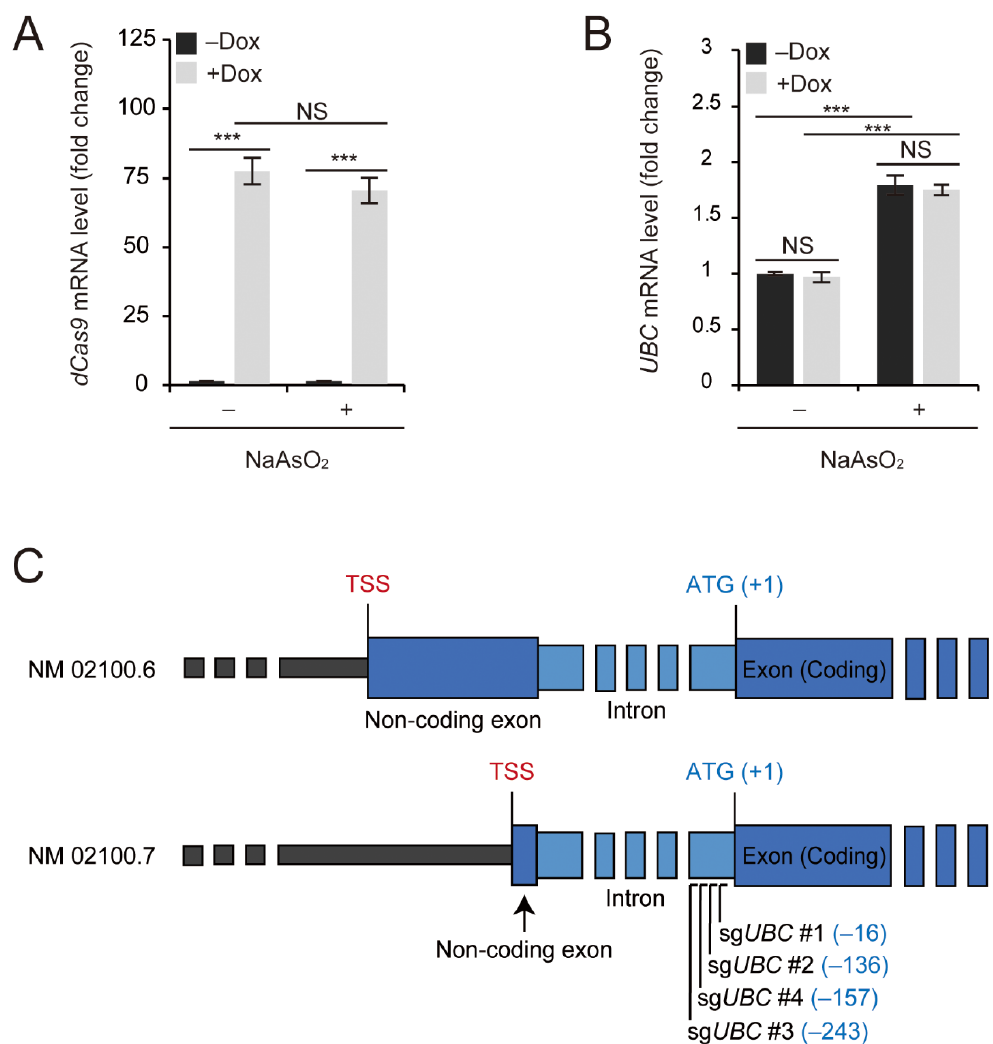
Figure 1. Inducible dCas9–VP64 (idCas9–VP64) system for the upregulation of the polyubiquitin gene UBC and the UBC promoter region. ( A , B ) Human embryonic kidney 293T (HEK293T) cells were transiently transfected with idCas9–VP64 and then treated with 5 μg/mL doxycycline (Dox) for 1 day. Before harvest, cells were treated with 10 μM NaAsO 2 for 5 h. dCas9 and UBC mRNA levels were determined by qRT-PCR ( n = 3 each), normalized to GAPDH , and expressed as the fold change relative to the control (-Dox, -NaAsO 2 ). ( C ) Structure of the polyubiquitin gene UBC based on the NCBI gene reference and indication of the designed sgRNAs targeting the intron of UBC . All data are presented as means ± SEM from the indicated number of samples. *** p < 0.001 between two groups as indicated by horizontal bars. NS: Not significant.